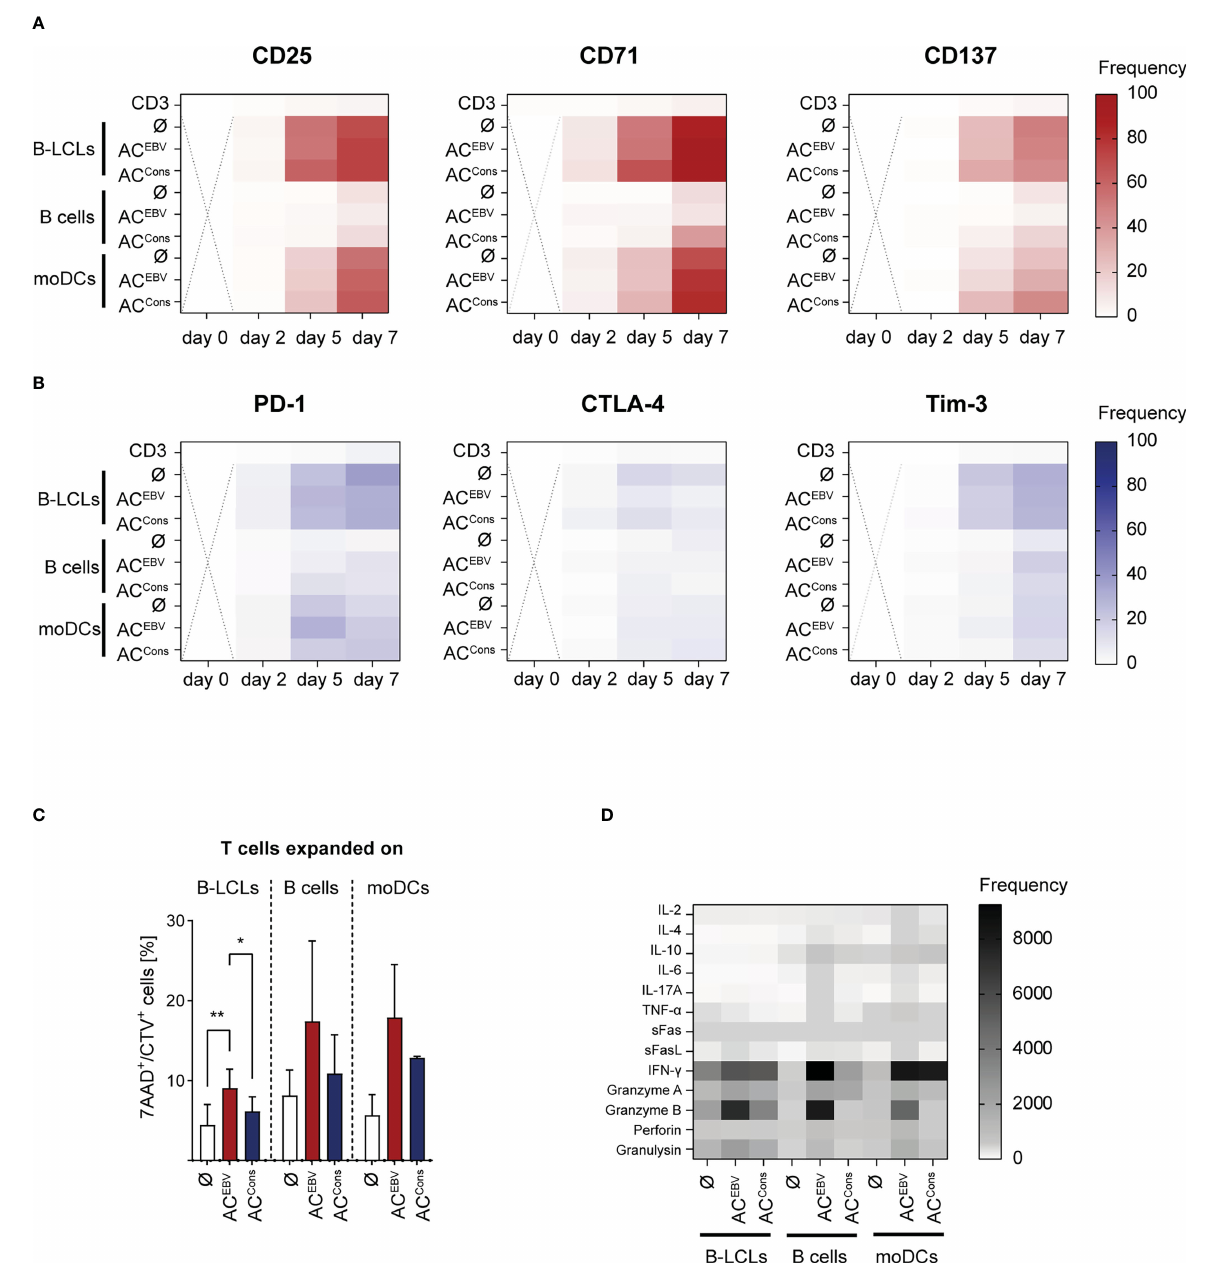
FIGURE 6 Characterization of EBV-speci fi c memory T cells stimulated by AC EBV cross-presentation. Heat maps display the expression of (A) activation maker and (B) exhaustion marker on CD3 + T cells from EBV-seropositive donors stimulated with AC EBV -loaded APCs on different days (day 0-7, n=4). CD3 + T cells alone and T-cell co-cultures with unloaded (Ø) or AC Cons -loaded APCs served as controls. The values are represented by different colors, as referenced in the bar. Statistical analysis was performed using the 2way ANOVA test followed by multiple comparison (ns - not signi fi cant). Dotted cross = not determined. (C) EBV-speci fi c T cells expanded on AC-loaded (AC EBV , AC Cons ) or unloaded APCs (Ø) for seven days were subjected to cytotoxicity assays using autologous unloaded B-LCLs as target cells in an effector to target ratio of 5:1. Frequencies of 7-AAD + cells among CTV + target cells (7AAD + /CTV + ) are shown. PBMCs or B cells served as negative target cells and values obtained from these co-cultures were subtracted. Results of independent experiments (B-LCLs and B cells: n=3, moDC: n=2) are displayed as mean ± SD. Statistical analysis was performed using the non-parametric Wilcoxon test (*p< 0.05; **p< 0.01). (D) Cell culture supernatants from cytotoxicity assays from day eight were analyzed with respect to presence of cytotoxic effector molecules by LEGENDPlex Assay. (B-LCLs and B cells: n=3, moDC: n=2). The values are represented by different colors, as referenced in the bar. Statistical analysis was performed using the 2way ANOVA test followed by multiple comparison. AC EBV - EBV antigen-containing cocktail, AC Cons - EBV Consensus peptide